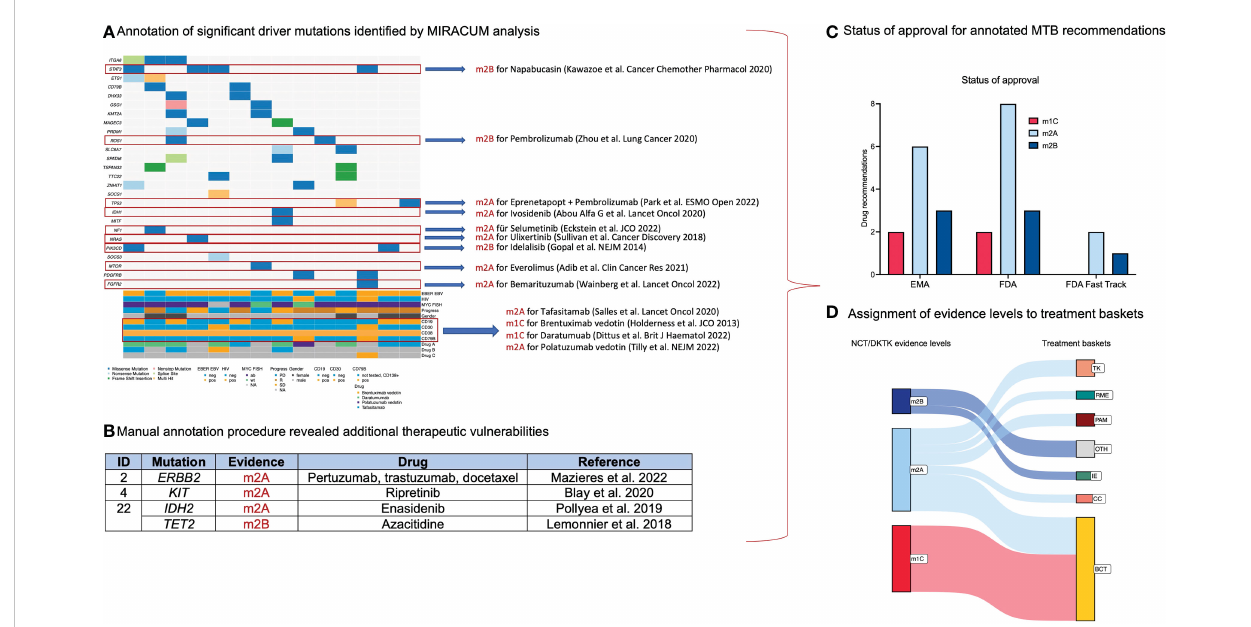
FIGURE 3 Results from manual database research and annotation of relevant genomic alterations. (A) Oncoplot summarizes relevant driver mutations and immunohistochemical targets detected upon MIRACUM pipeline analysis and potential therapeutic options. (B) Additional therapeutic vulnerabilities resulting from manual annotation procedure. (C) Bar plot visualizing the status of approval for annotated therapeutic options. (D) Sankey plot assigning molecular evidence levels to treatment